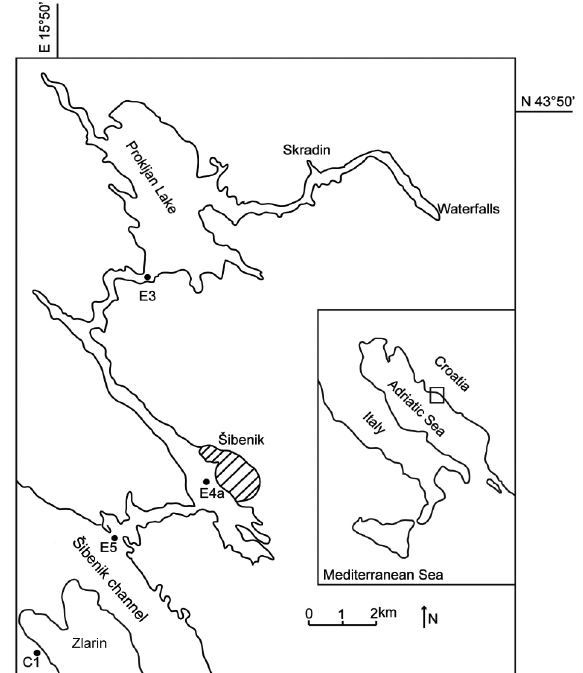
Fig. 1. – Map of the investigated area showing estuarine (E3, E4a, E5) and coastal (C1) sampling